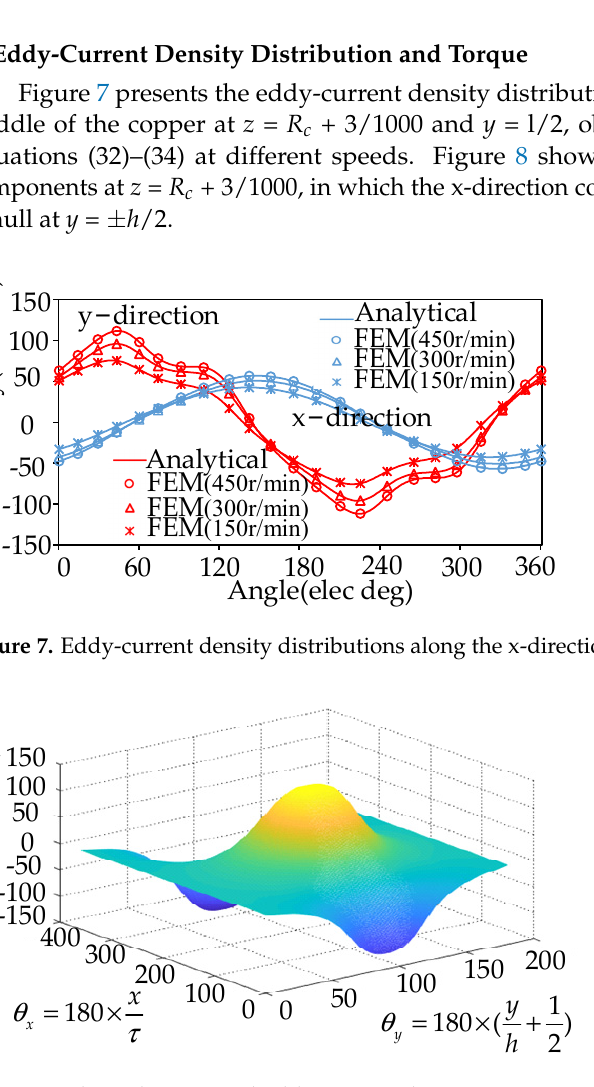
Figure 8. Three-dimensional eddy-current density components distribution in the middle of the copper at 300 rpm.